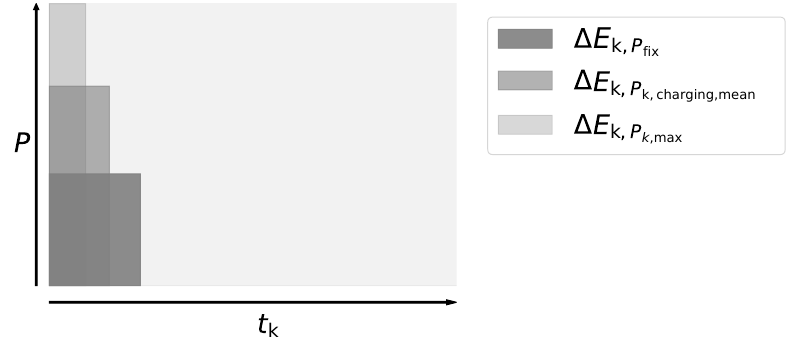
Figure 14. FlexBars for the logistics